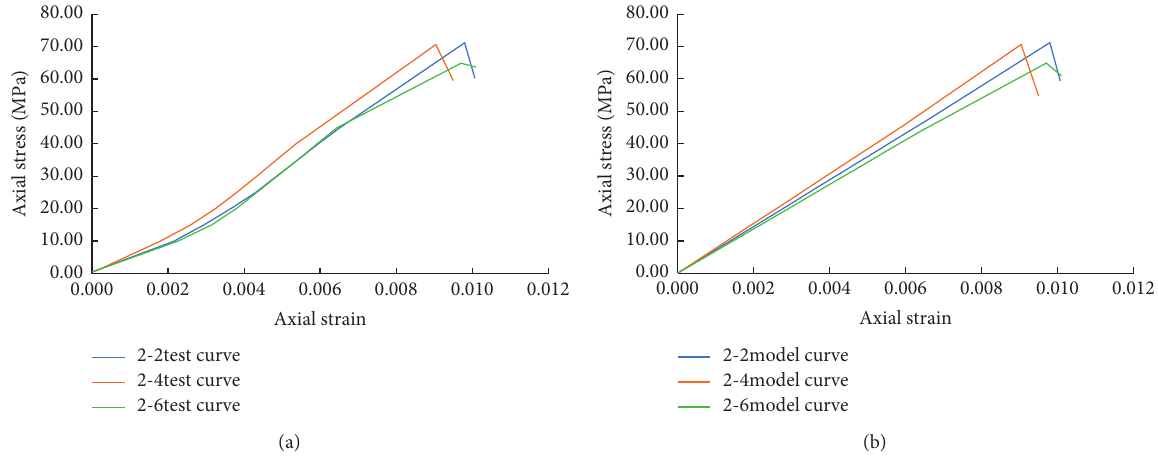
Figure 5: Stress-strain curve (II) of filled cracked rocks with cement mortar ( σ